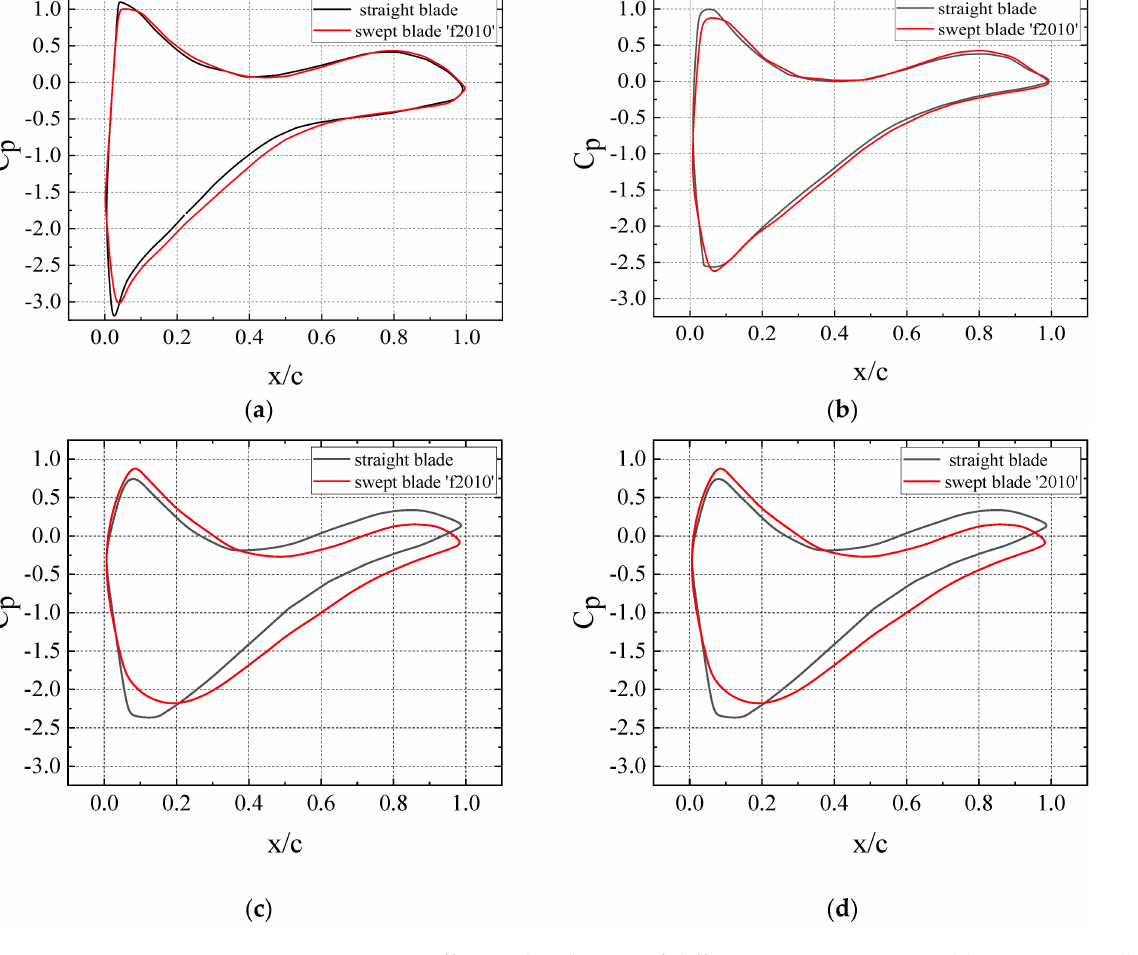
Figure 5. Pressure coefficient distribution of different sections at λ = 5. ( a ) 35% section; ( b ) 65% section; ( c ) 80% section; ( d ) 95%